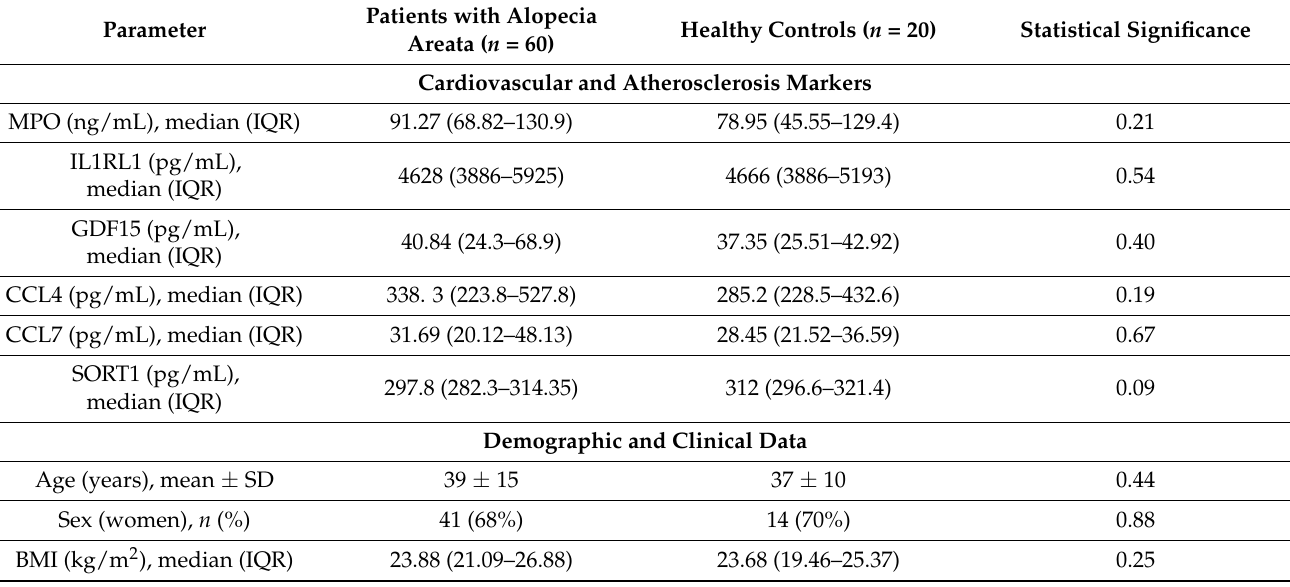
Table 1. Baseline patient characteristics and the assessment of cardiovascular and atherosclerosis markers. Patients with Alopecia Parameter Healthy Controls ( n = 20) Statistical Significance Areata ( n = 60) Cardiovascular and Atherosclerosis